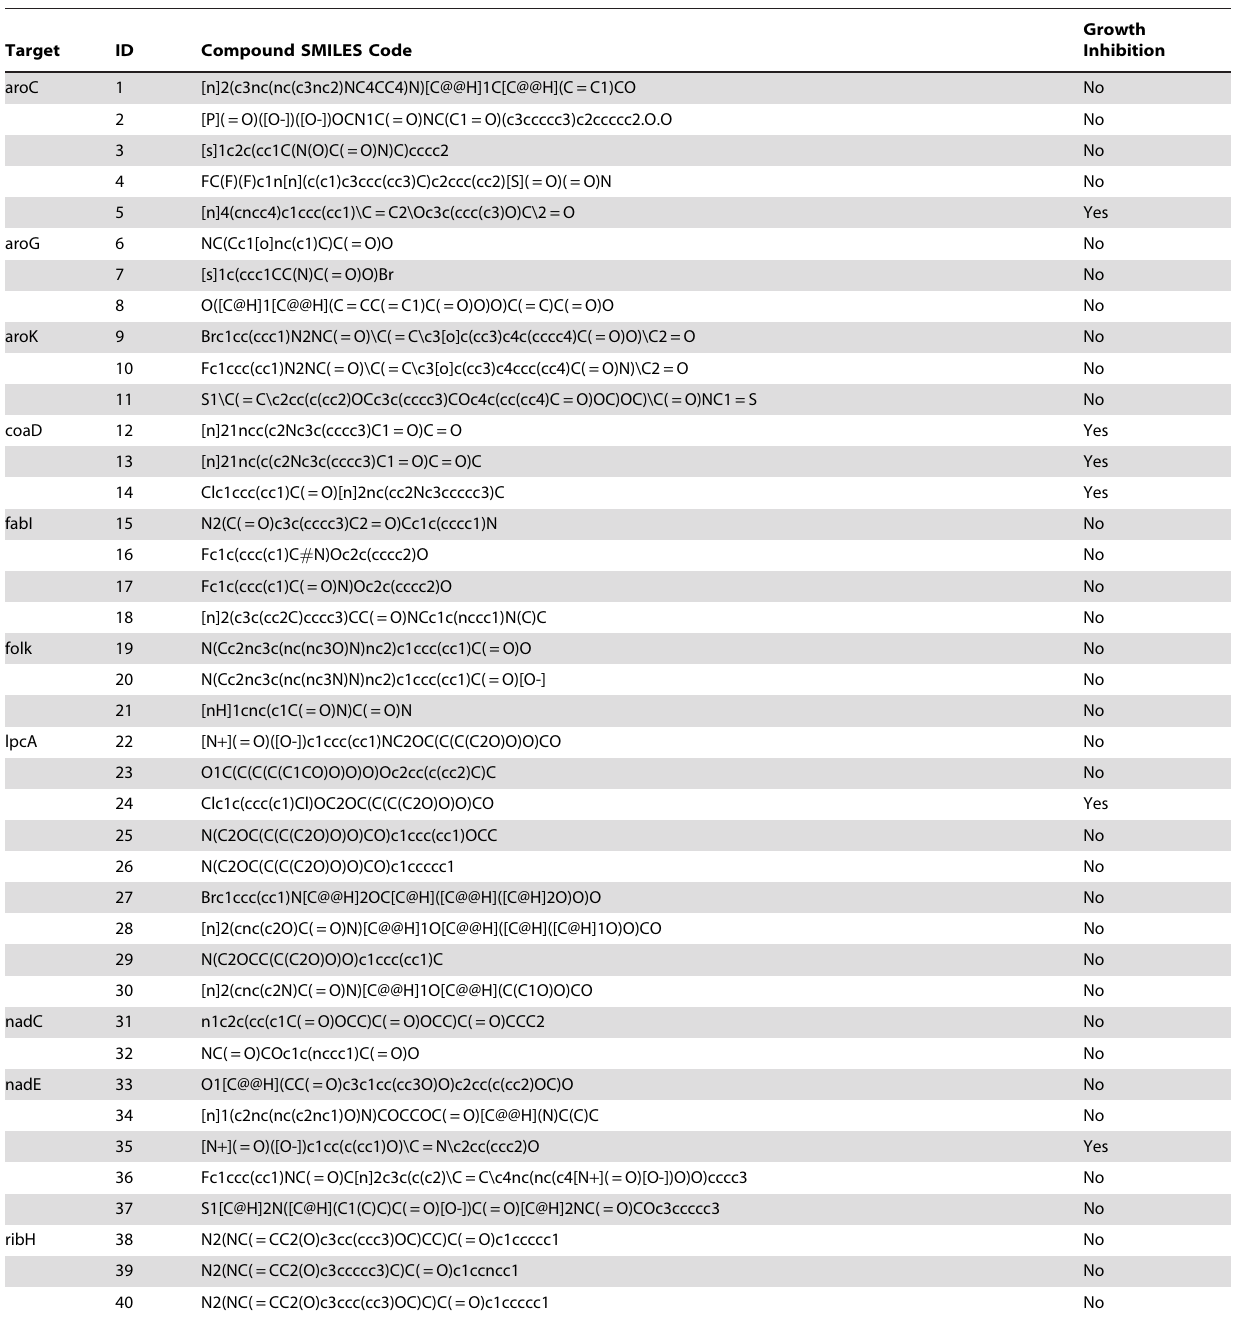
Table 3. Growth inhibition property of tested